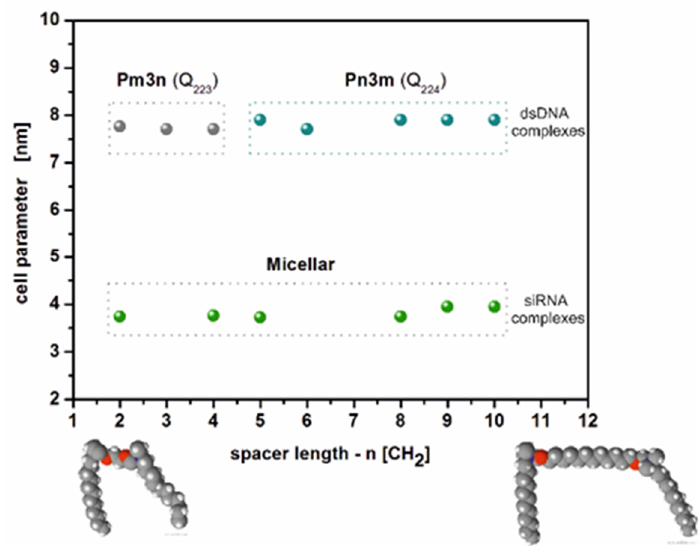
Figure 7. Spacing parameters for the cubic and micellar phase formed in the tested mixtures as a function of surfactants’ spacer length. Molecular models – oxygen (red), nitrogen (blue), carbon (gray) and hydrogen (white).